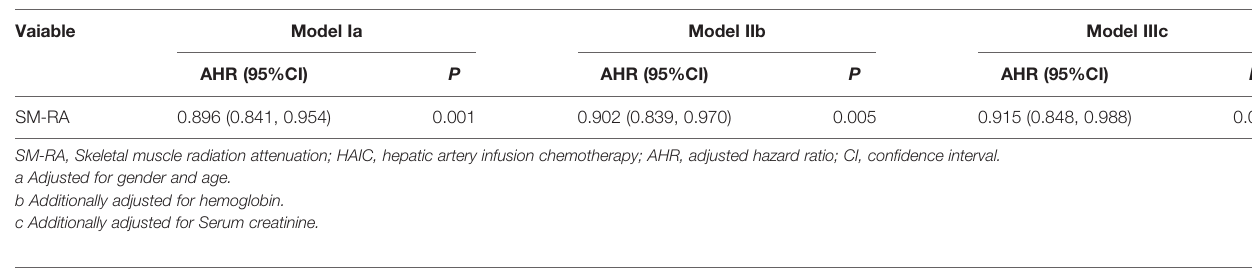
TABLE 4 | Associations of lower SM-RA with overall survival (OS) of HAIC combined with immunotherapy in 52 patients with advanced HCC. Vaiable